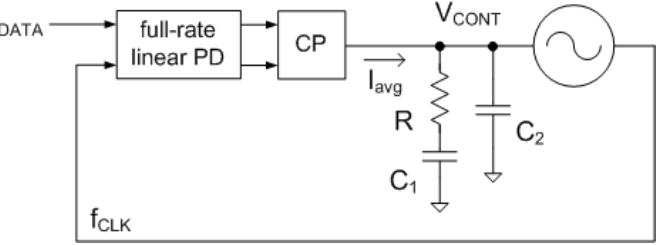
Figure 5. The frequency-locked loop model.